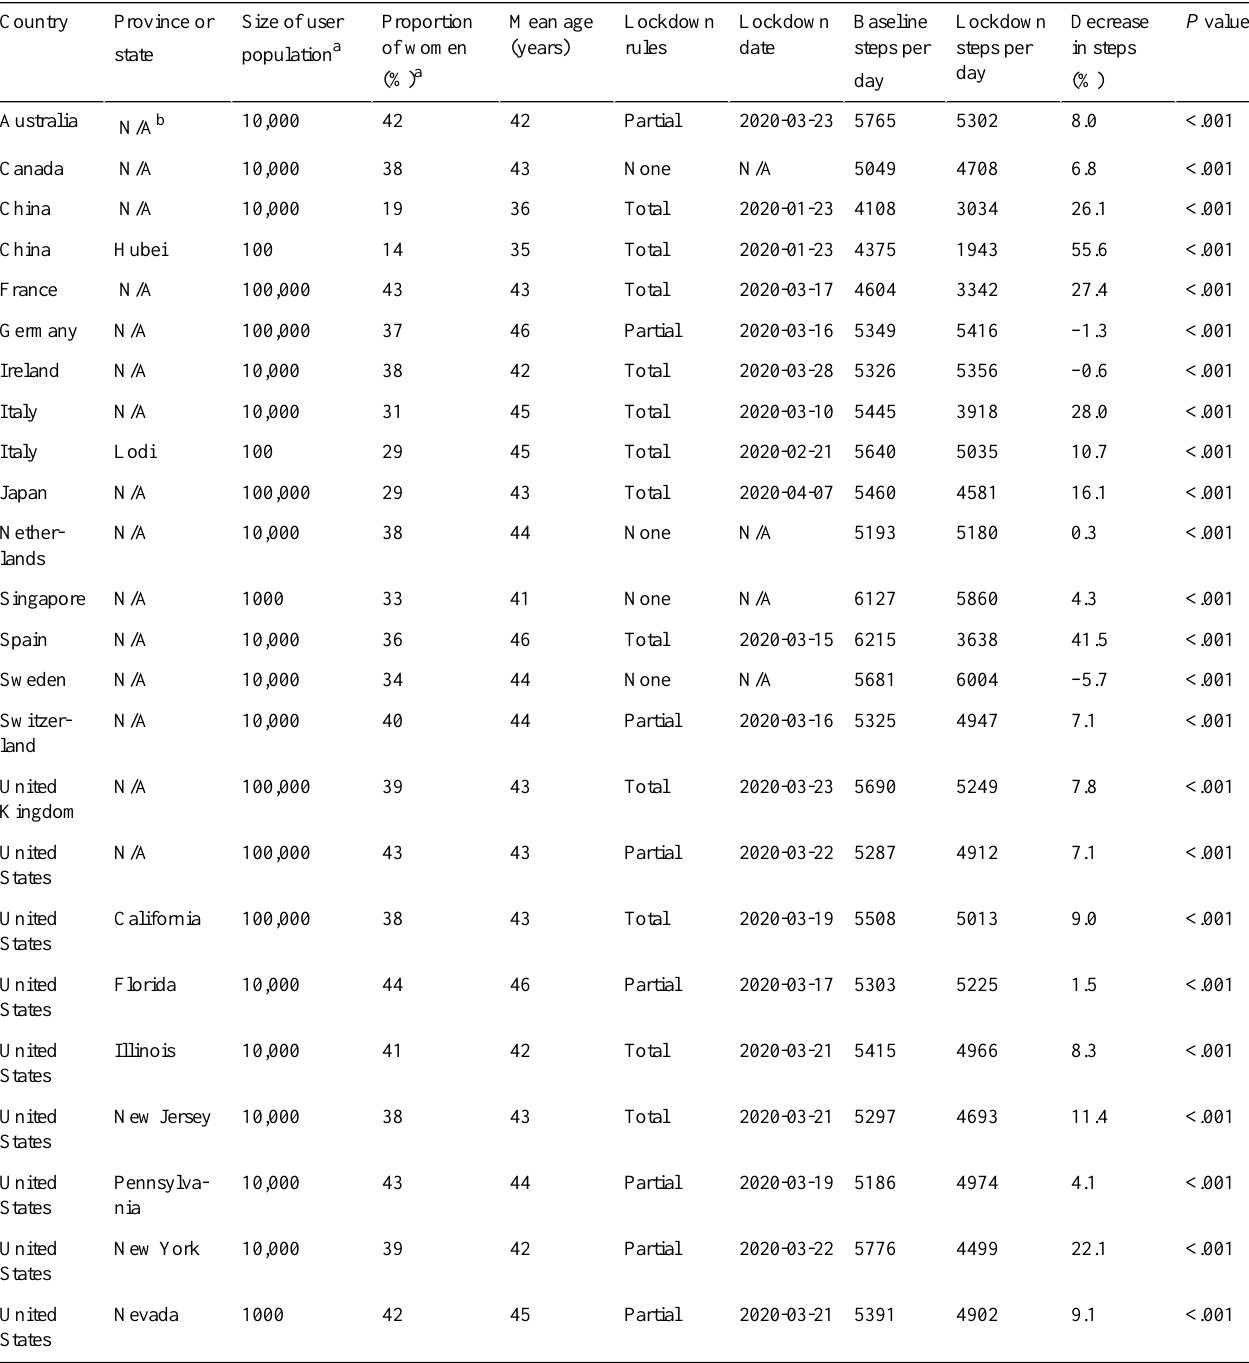
Table 1. Characteristics of the studied population.